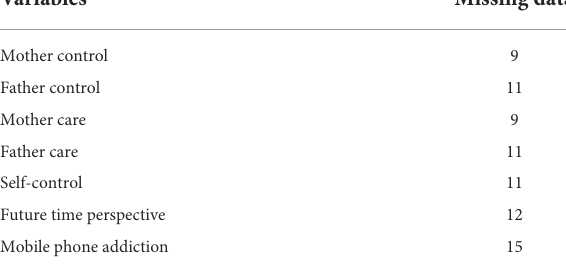
TABLE 1 The missing data of